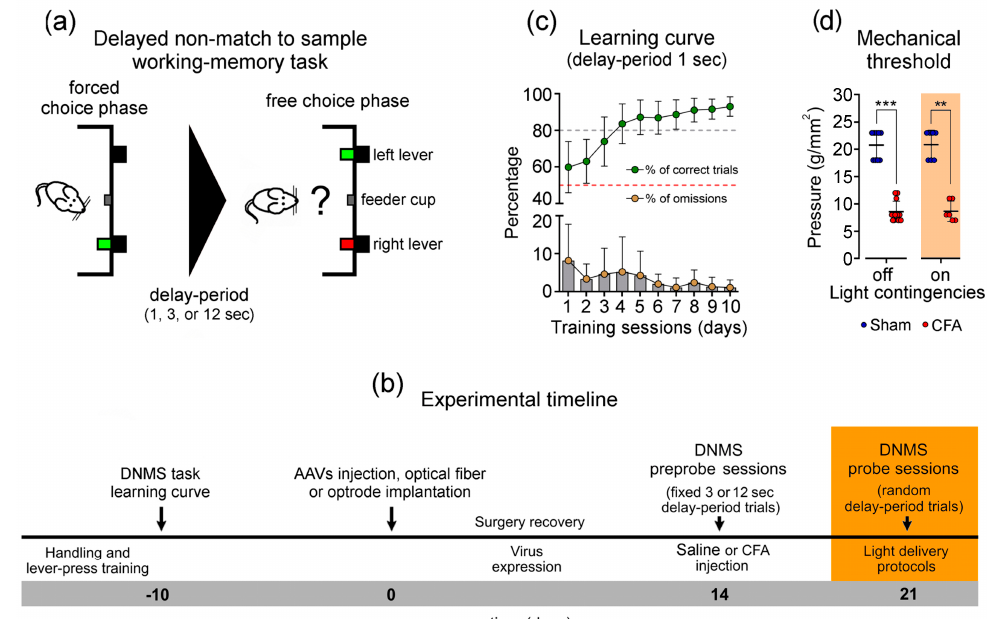
Figure 1. Working memory task, learning curve, and experimental timeline. ( a ) Diagram of delayed non-match to sample (DNMS) WM task used in this study. Each trial began with a single lever being exposed (forced-choice phase). When the rat pressed the lever, it was retracted and the delay-period was initiated. At the end of this period, both levers were exposed (free-choice phase), and to obtain a reward pellet, the rat needed to press the opposite lever selected in the forced-choice phase. ( b ) Timeline of the experimental protocol. In brief, after the learning curve each rat was injected with a virus to express eNpHR3.0 opsin in LHb neurons projecting to VTA, and implanted with an optical fiber in the VTA. After postoperative recovery (14 days), rats were subjected to saline injection (Sham group) or an inflammatory pain model (CFA group) and trained in the DNMS task using six-day single delay-period contingencies (3 or 12 s; ahead referred as pre-probe sessions). Optogenetic neuromodulation protocols were applied 7 days after saline or CFA injection (probe sessions). Light delivery was applied during the delay-period of the DNMS task using a fixed intensity of 5–6 mW at the fiber tip. Each probe session was composed of a random sequence of 3 and 12 s delay-period challenge trials, in equal numbers. Light neuromodulation protocols were applied in independent probe sessions. ( c ) DNMS task learning curve, gain in performance during 10 consecutive training sessions using a delay-period challenge of 1 s (top panel), and corresponding percentage of performed omissions (bottom panel). ( d ) Effects of contralateral photoinhibition of LHb neurons projecting to VTA in mechanical sensitivity threshold. Comparisons between experimental groups and light delivery protocols were based on non-parametric Kruskal-Wallis (KW) test followed by post hoc Dunn’s test. Values are presented as mean ± S. D. Significant results are indicated by ** when p < 0.01, and *** when p < 0.001.